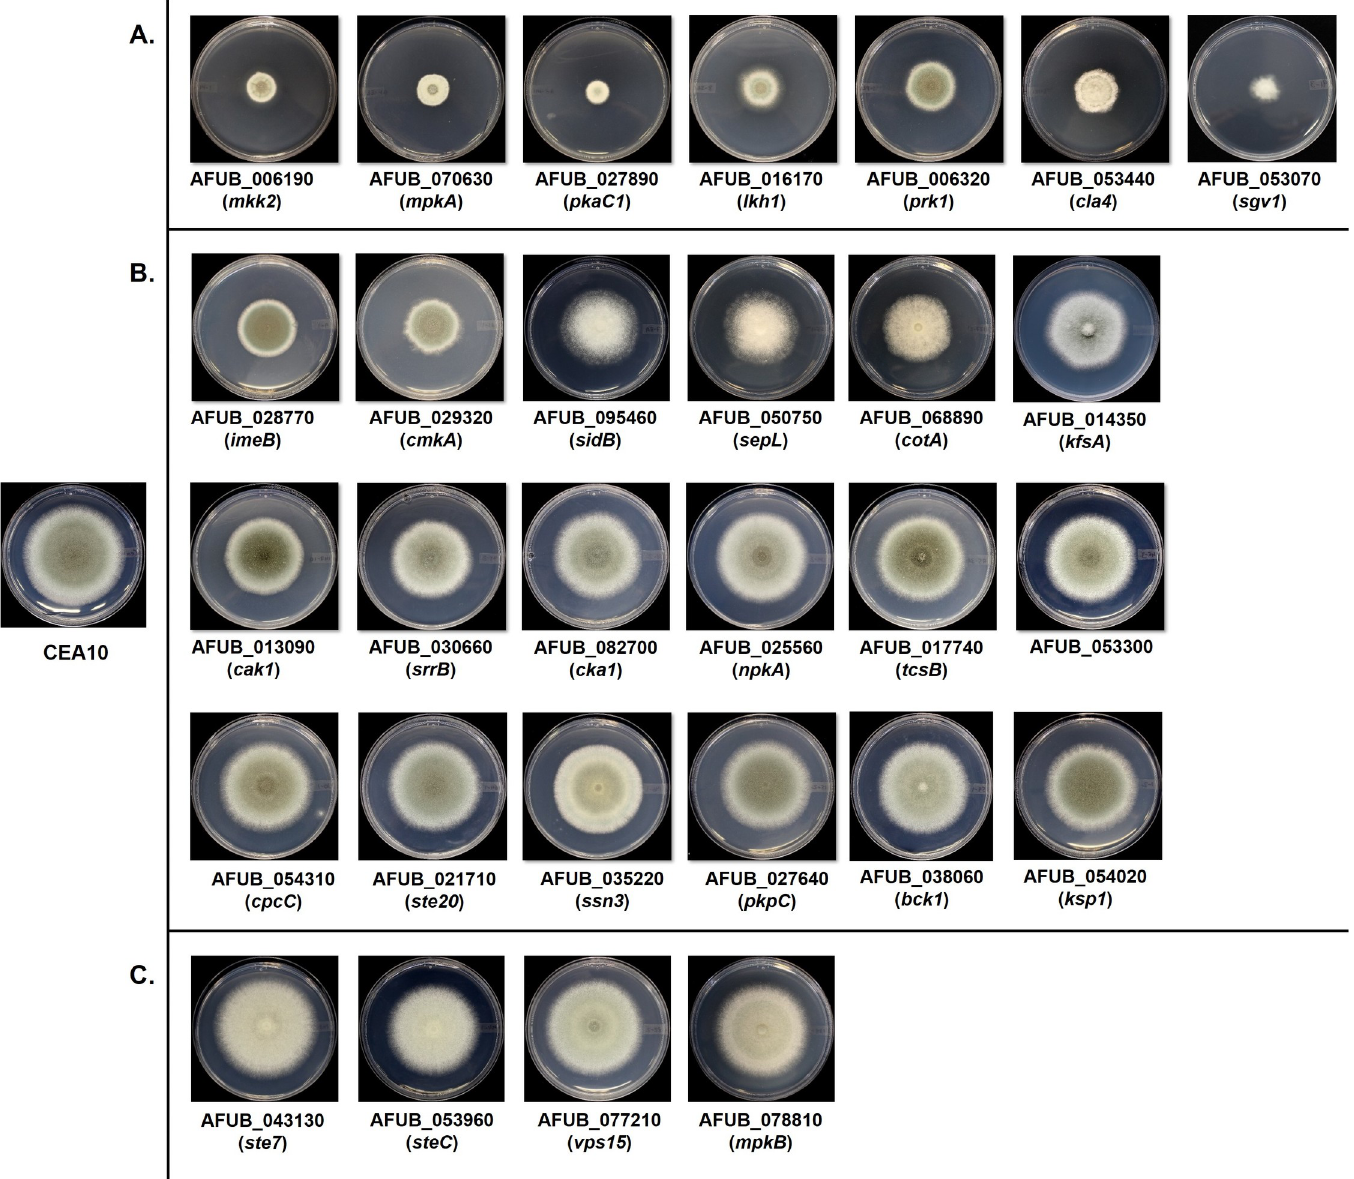
Fig 2. Colony morphologies of selected A . fumigatus protein kinase disruption mutants. 96-hr colony morphologies of severely (A) and moderately (B) growth restricted protein kinase disruption mutants, as well as colony morphologies of mutants that are not growth restricted but display reduced conidiation (C) . Ten thousand conidia from each strain were point inoculated onto the center of minimal media agar and cultured for 96 hrs at 37˚C.